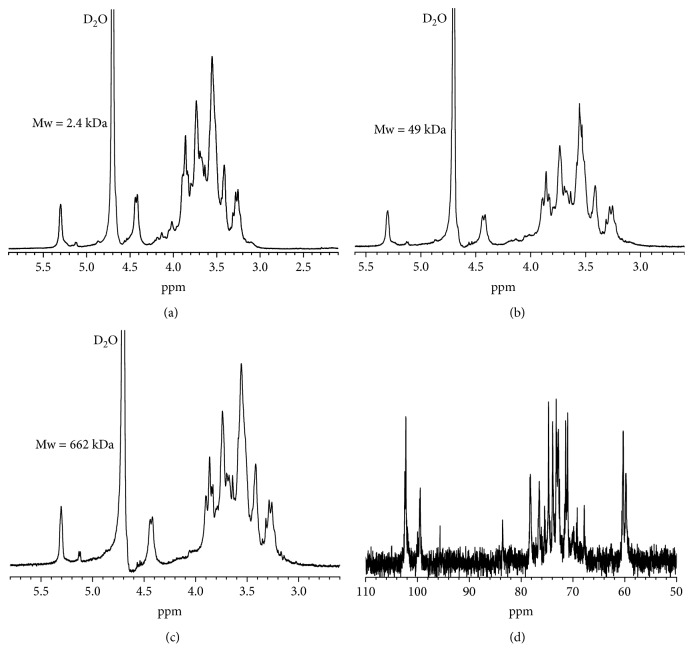
NMR spectra of GLP. (a–c) 1H NMR spectra and (d) 13C NMR spectrum.